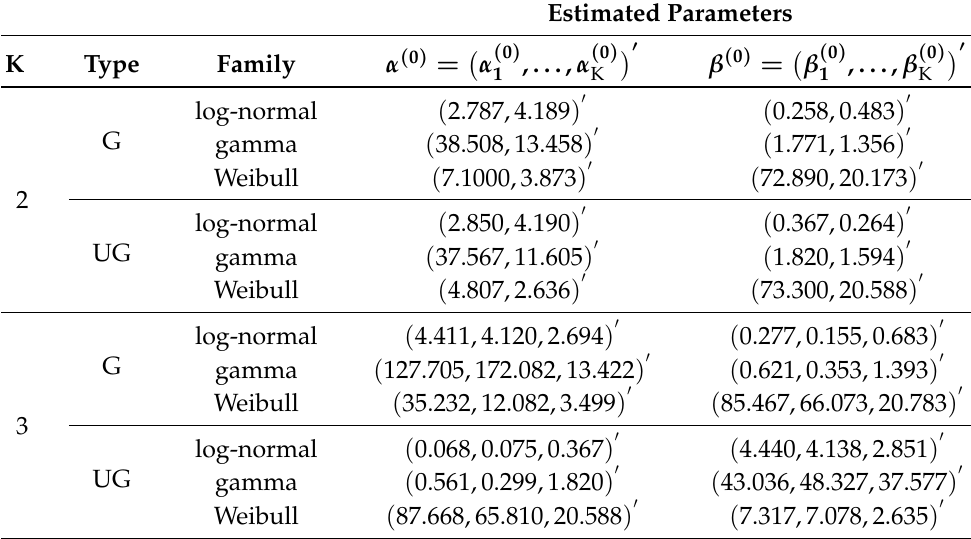
Table A1. Initial values of the EM algorithm for sample 1 obtained using the K-means clustering approach when DBH data are ungrouped (UG) and grouped (G) in classes of width 5 cm. It should be noted that the estimated vector of mixing parameters is not given for the sake of saving space.